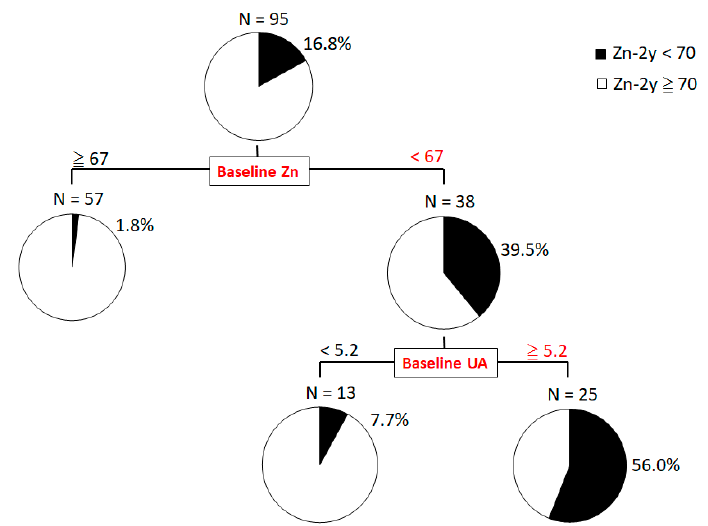
Figure 1. Decision-Tree Algorithm for Zn-2y Deficiency. The decision-tree algorithm for specifying the factors leading to Zn-2y < 70 µ g/dL, showed that low baseline Zn (Zn < 67 µ g/dL) was the